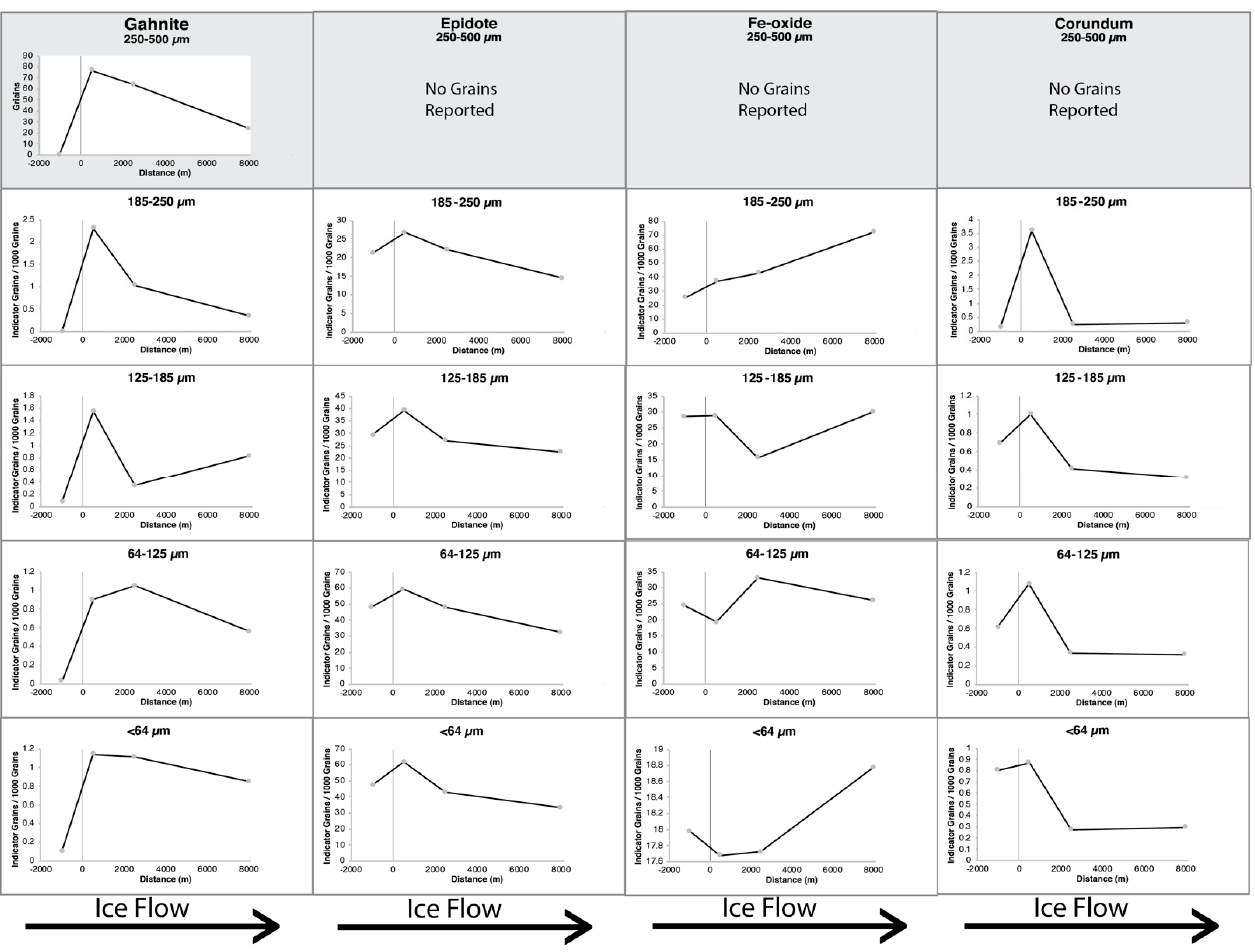
Figure 8. The grain abundance (normalized to 1000 grains) of key alteration indicator minerals at each sample location, for each size fraction examined. The X-axis of each is a scaled representation in the direction of ice flow (black arrow). The location of mineralization is denoted by the vertical grey line, and the black trend-line depicts the inferred decay in indicator mineral abundance along the dispersal train extending from the deposit.